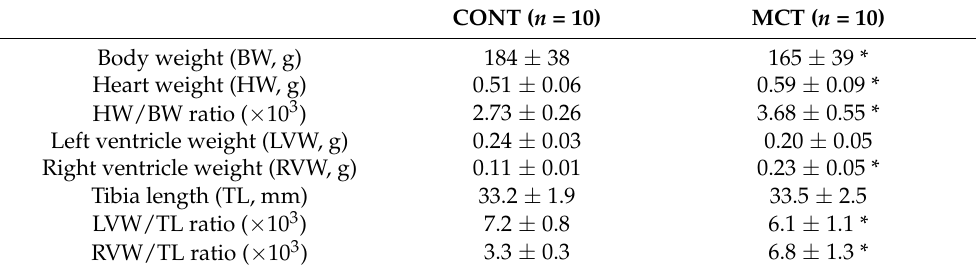
Table 1. Morphometric indices for healthy (CONT) and monocrotaline-treated (MCT) rats. CONT ( n = 10) MCT ( n = 10) Body weight (BW, g) 184 ± 38 165 ± 39 * Heart weight (HW, g) 0.51 ± 0.06 0.59 ± 0.09 * HW/BW ratio ( × 10 3 ) 2.73 ± 0.26 3.68 ± 0.55 * Left ventricle weight (LVW, g) 0.24 ± 0.03 0.20 ± 0.05 Right ventricle weight (RVW, g) 0.11 ± 0.01 0.23 ± 0.05 * Tibia length (TL, mm) 33.2 ± 1.9 33.5 ± 2.5 LVW/TL ratio ( × 10 3 ) 7.2 ± 0.8 6.1 ± 1.1 * RVW/TL ratio ( × 10 3 ) 3.3 ± 0.3 6.8 ± 1.3